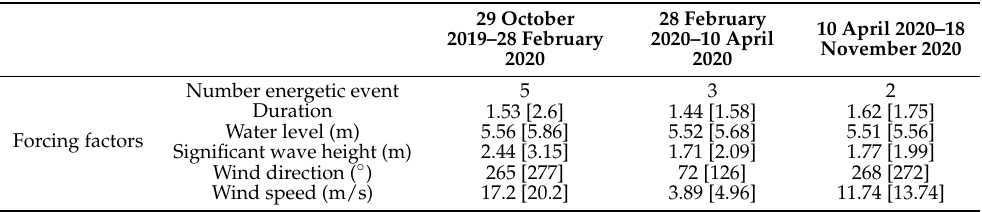
Table 2. Summary of hydrodynamic conditions over the monitoring period. Energetic event is characterized by a water level above 5.4 m